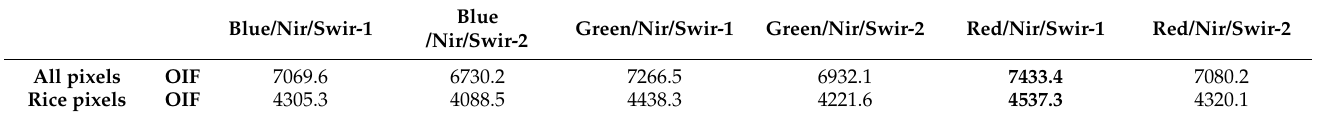
Table 2. The OIF indexes corresponding to all possible band combinations.